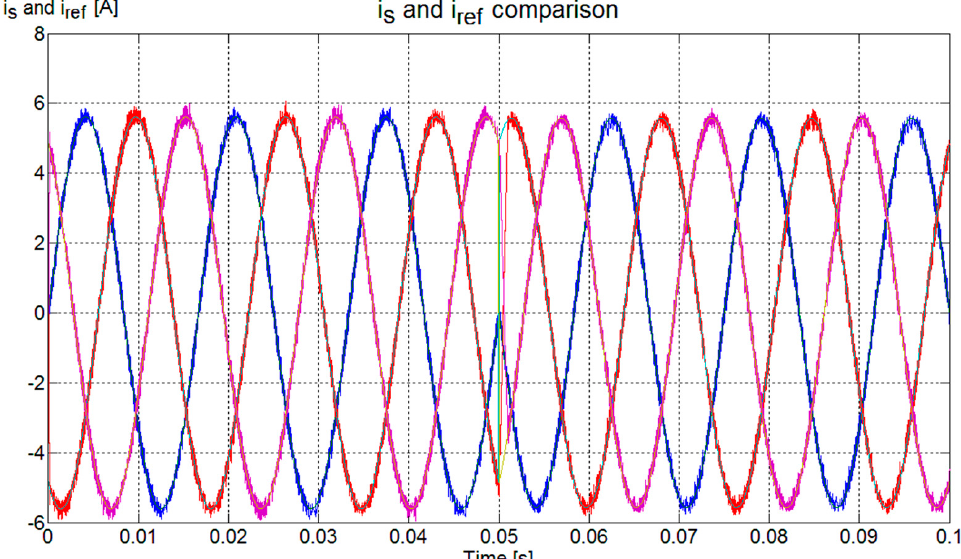
Figure 14. Reference source current waveform, i ref , and measured current waveform, i s (red, blue and violet), when a power step from 1.5 kW to − 1.5 kW is applied at 50 ms.